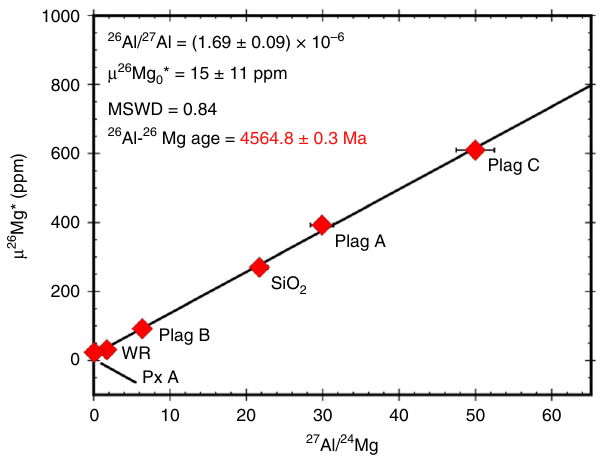
Fig. 5 The Al – Mg internal isochron de fi ned by whole rock (WR) and mineral separates of NWA 11119. This isochron corresponds to a 26 Al/ 27 Al ratio of (1.69 ± 0.09) × 10 − 6 . Relative to the D ’ Orbigny age anchor, NWA 11119 has a 26 Al – 26 Mg age of 4564.8 ± 0.3 Ma. The uncertainties on the µ 26 Mg* values are either the internal 2SE errors (2× the standard error) on repeat analyses of the sample or the 2 SD (2× the standard deviation) external reproducibility based on repeat analyses of standards, whichever is larger; the uncertainties on the 27 Al/ 24 Mg ratios are polymict ureilite Almahata Sitta 3 , and the basaltic ungrouped achondrite NWA 7325 20 – 22 are the only other known achondrites that plot at high δ 18 O values (>4 ‰ ) along the CCAM line. The ungrouped achondrites NWA 3133 23 , NWA 8186 24,25 , and NWA 7822 26 plot at lower δ 18 O (<4 ‰ ) along the CCAM line, and show strong links to carbonaceous chondrite meteorite groups.